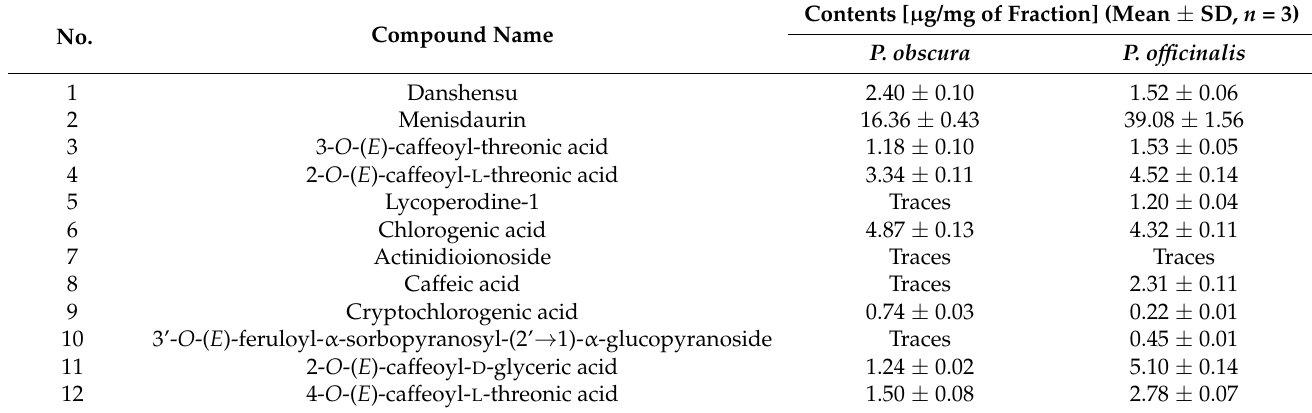
Table 2. Metabolite content in the examined phenolic-rich fractions, isolated from aerial parts of P. obscura and P. officinalis .